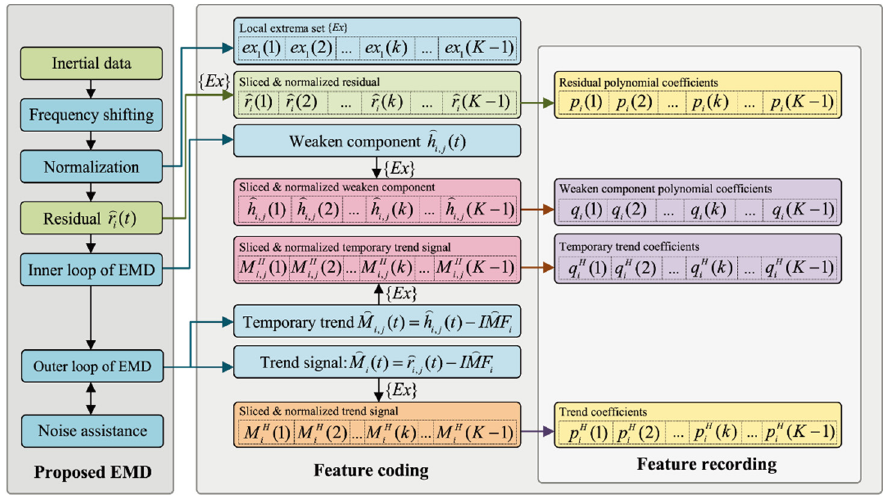
Figure 4. Modified EMD with data recording.